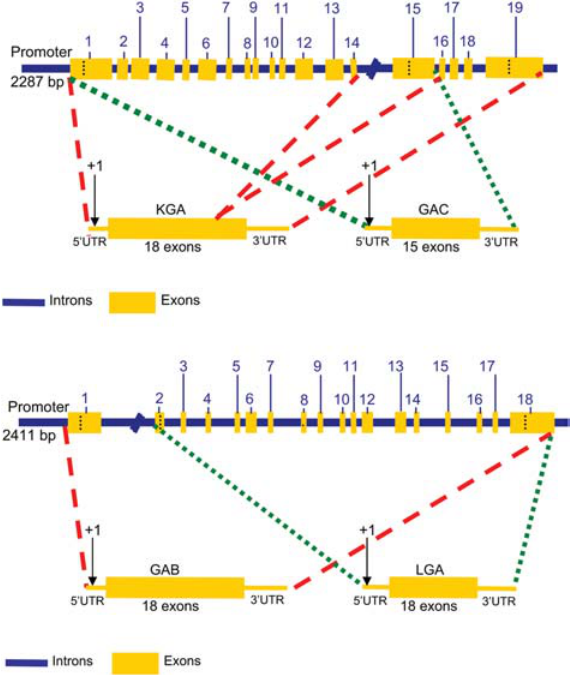
Figure 1 Human glutaminase genes and mRNA transcripts. (Top panel) Human glutaminase Gls gene and alternative transcripts KGA and GAC. (Bottom panel) Human glutaminase Gls2 gene and transcripts GAB and LGA. Each gene is shown with introns depict- ed as solid blue lines and exons as numbered yellow boxes. The promoter regions are also indicated on the 5 9 -end of each gene. Dashed red lines indicate the exons forming KGA and GAB mRNA transcripts, whereas dotted green lines comprise exons involved in the generation of transcripts GAC and LGA. The transcription start site is marked by an arrow and numbered as q 1. (For further infor- mation see